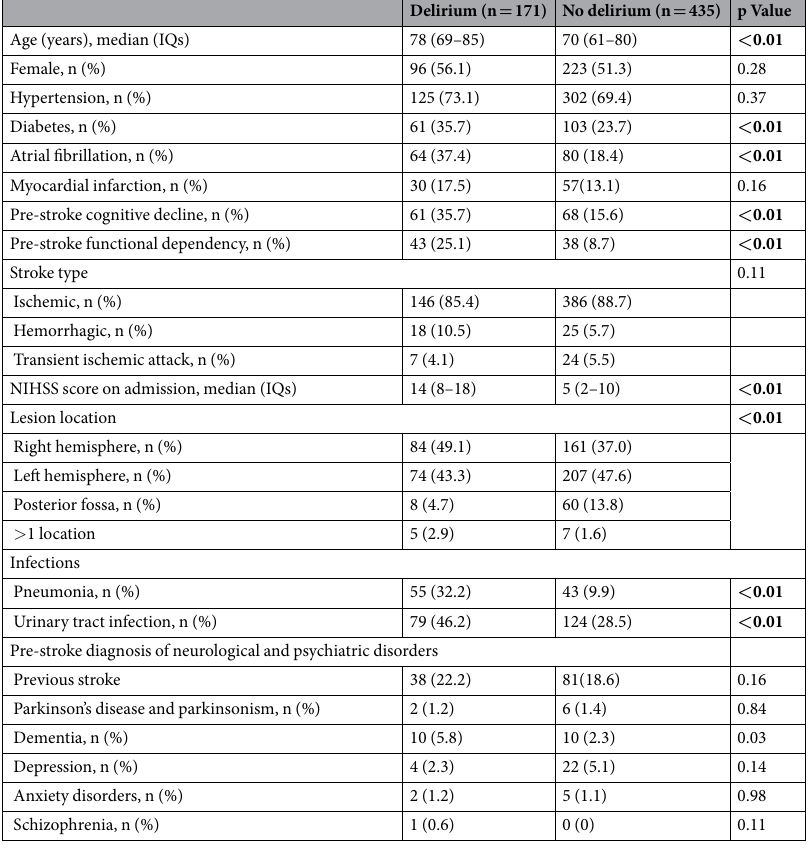
Table 1. Baseline characteristic of patients with delirium and patients without delirium. IQs – interquartiles; NIHSS – National Institute of Health Stroke Scale.